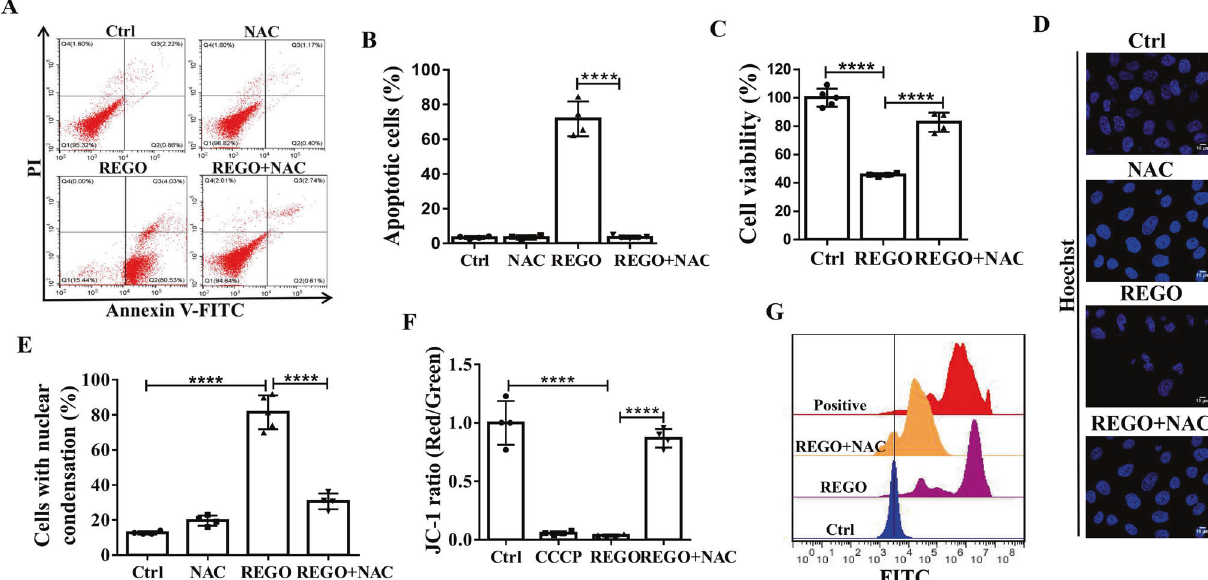
Fig. 2 REGO induces ROS-dependent apoptosis in MCF-7 cells. A , B Flow cytometry analysis on REGO-induced apoptosis. C REGO induced ROS-dependent cytotoxicity measured by CCK-8 assay. Cells were pretreated with NAC (10 mM) for 2 h, followed by co-treatment with REGO at 20 μ M for 24 h. D REGO induced ROS-dependent nuclear condensation detected by Hoechst 33258 staining (×600). E Statistical percentages of cells with nuclear condensation. N ≥ 100 cells. F REGO-induced loss of mitochondrial membrane potential by using JC-1 probe. G REGO signi fi cantly increased intracellular ROS. ** p < 0.01, *** p < 0.001, **** p < 0.0001. All data are expressed with the mean ± SD of three independent